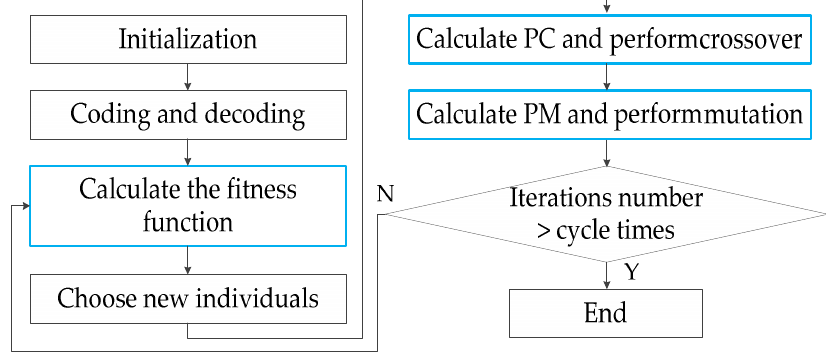
Figure 2. Error-limited genetic algorithm (ELGA) flowchart.